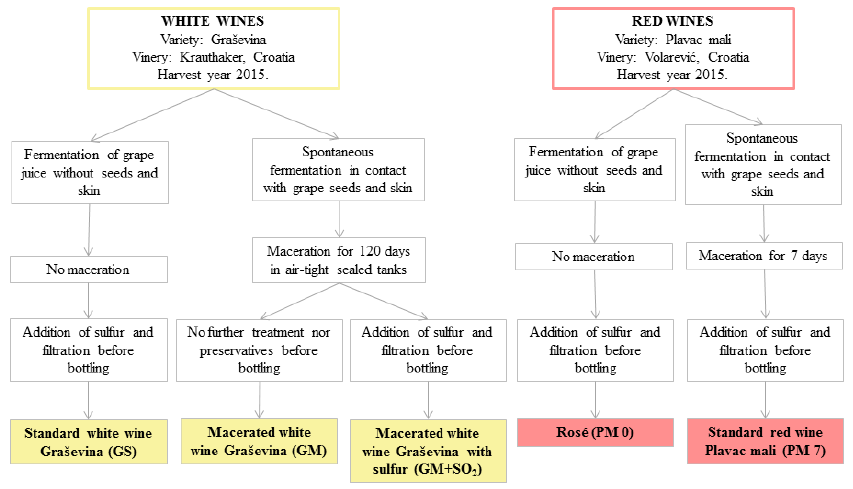
Figure 1. Technology of the tested wines.